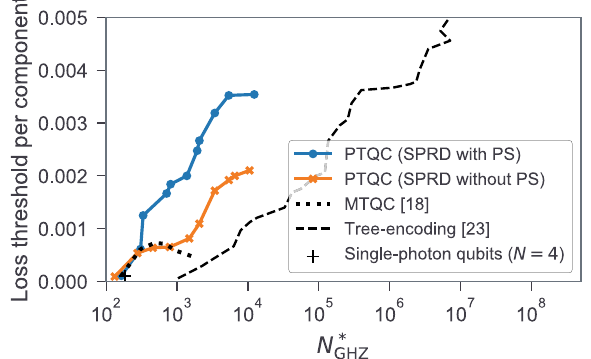
Fig. 7 Comparison of PTQC and three known approaches, in terms of the photon loss threshold per component as a function . The loss thresholds per component are obtained while of N (cid:1) GHZ assuming the same photon loss rate between single-photon sources, beam splitters, delay lines, switches, and photodetectors. The values for the tree-encoding approach are those reported in Fig. 4b of Ref. 24 . The value for the single-photon-qubit approach is obtained by using the boosted BSM scheme of N = 4 in Ref. 19